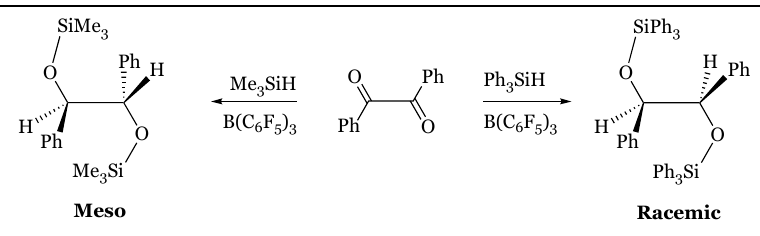
Figure 31. Meso selectivity of α -diketones reacted with tetraphenyldisilane.